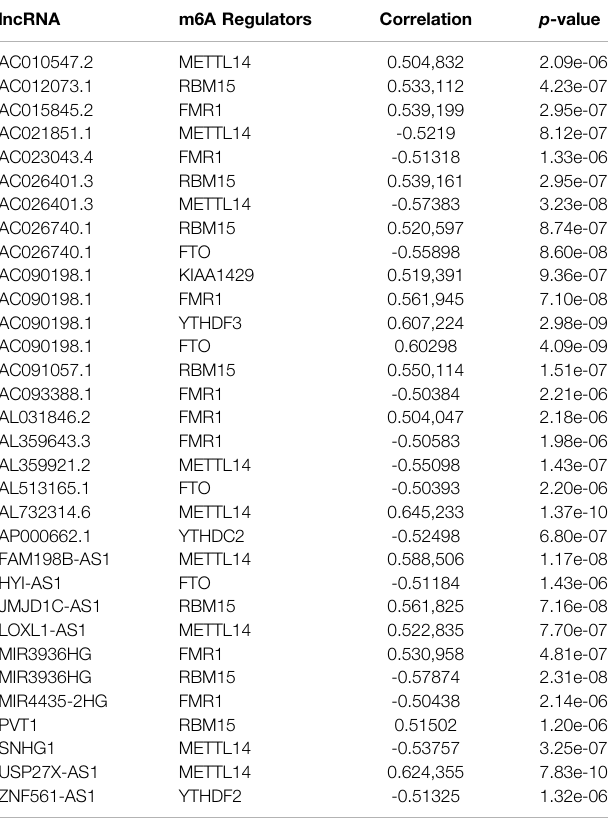
TABLE 2 | The correlation coef fi cients between the 26 lncRNAs and m6A regulators. lncRNA